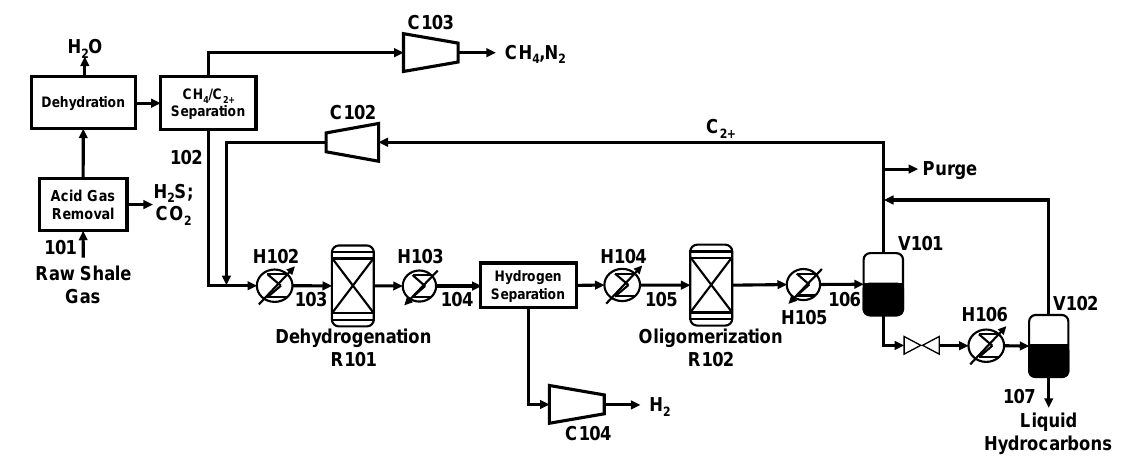
Figure 3. Process flow sheet for Process